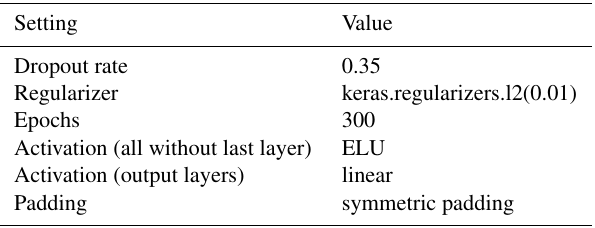
Table A4. Specific information and rates used to set up the model